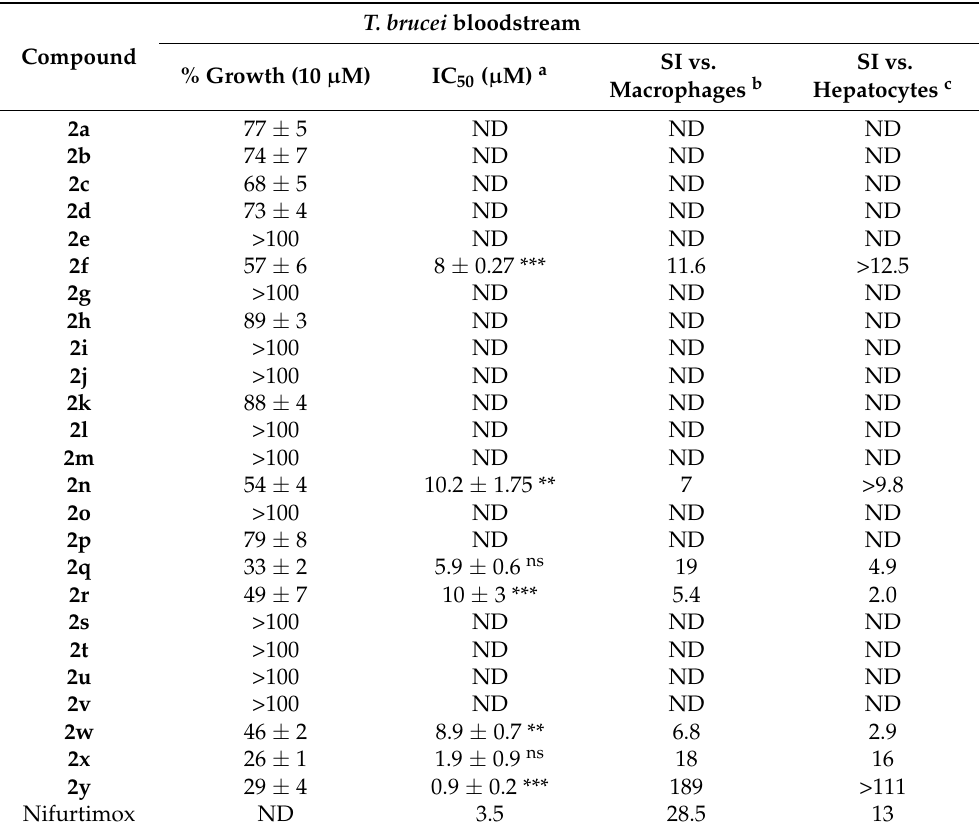
Table 3. Anti-trypanosomal activity and selectivity of 4,4 (cid:48) -(arylmethylene)bis(3-methyl-1-phenyl-1 H - pyrazol-5-ols) 2a –